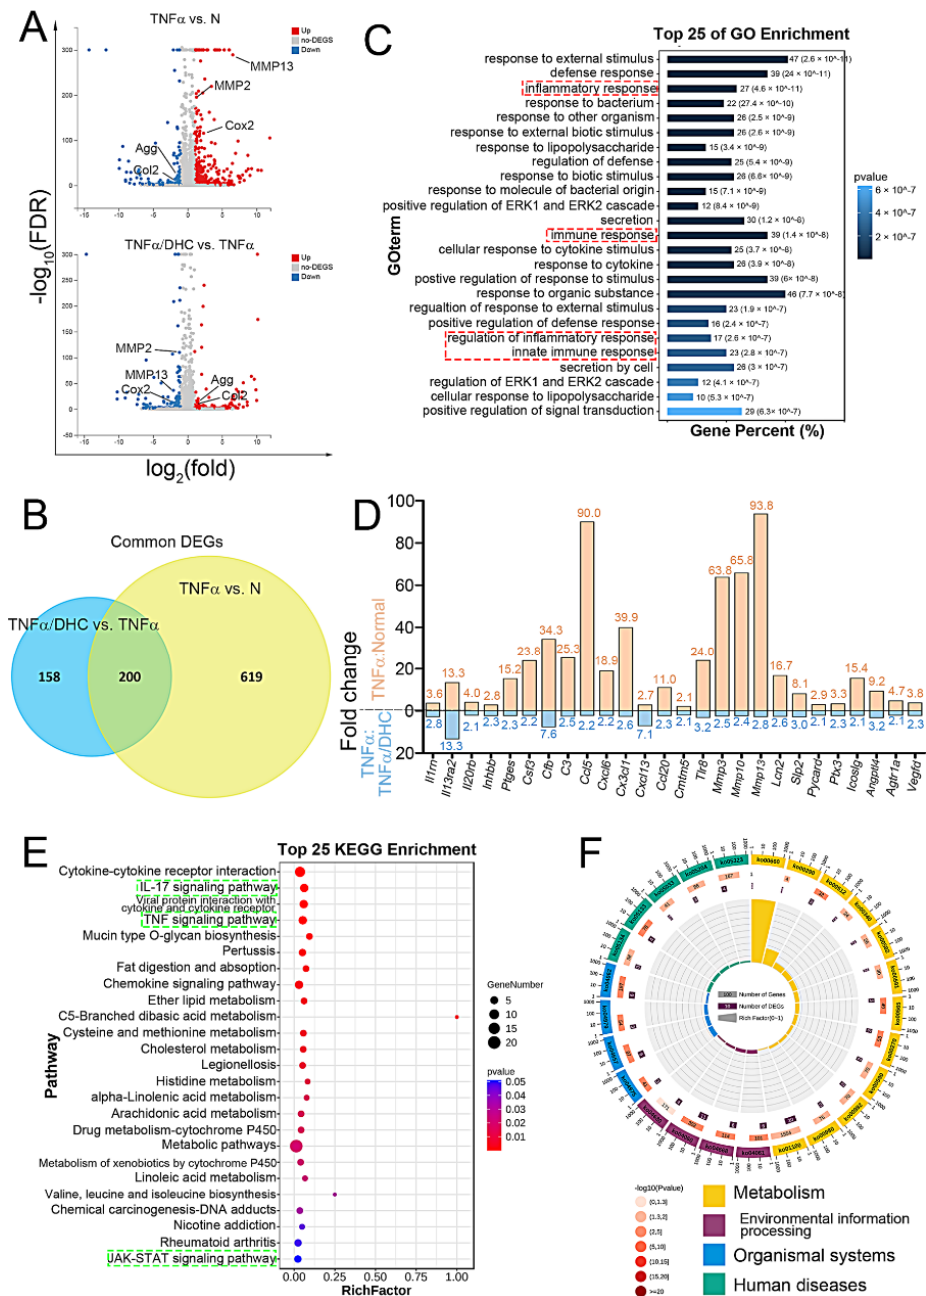
Figure 3. Dehydrocorydaline (DHC) regulated the gene expression profiles in the TNF α -treated human chondrocytes after 48 h. ( A ) Differently expressed genes (DEGs) in human chondrocytes between the normal group and TNF α group (819 DEGs), and TNF α group and TNF α + 10 µ M DHC group (358 DEGs), were analyzed through Volcano plot. ( B ) Common DEGs of the 819 and 358 DEGs detected through Venn diagram analysis. ( C ) Gene ontology (GO) analysis of the common DEGs. ( D ) Fold change (FC) expression of inflammatory factors. Kyoto Encyclopedia of Genes and Genomes (KEGG) analysis showed in ( E ) gradient and ( F ) circular